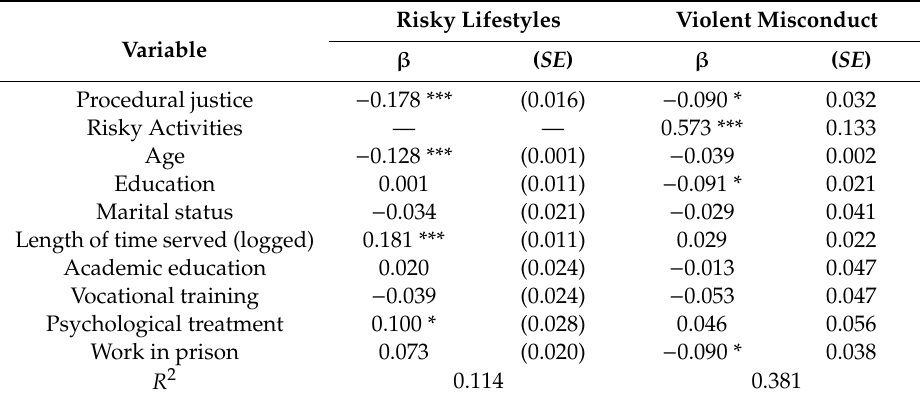
Table 3. Summary of OLS regression coefficients.